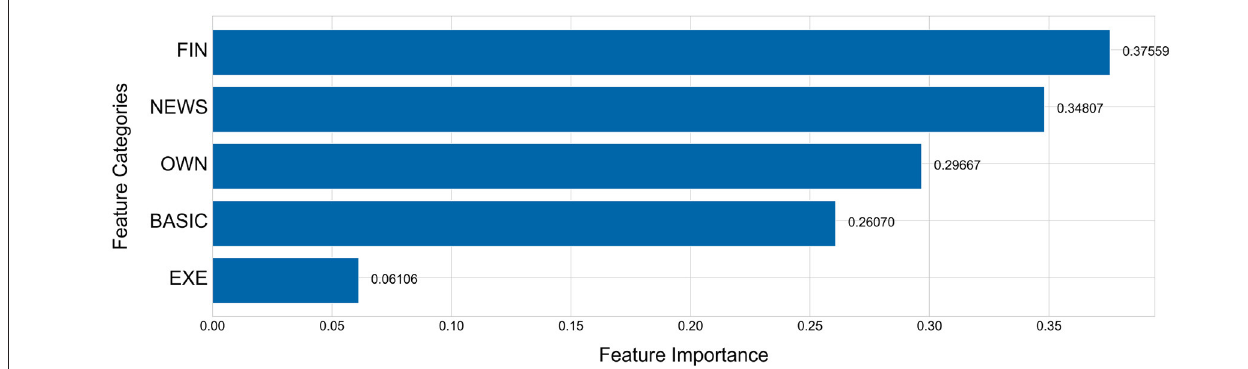
FIGURE 5 | Feature importance of every feature category.